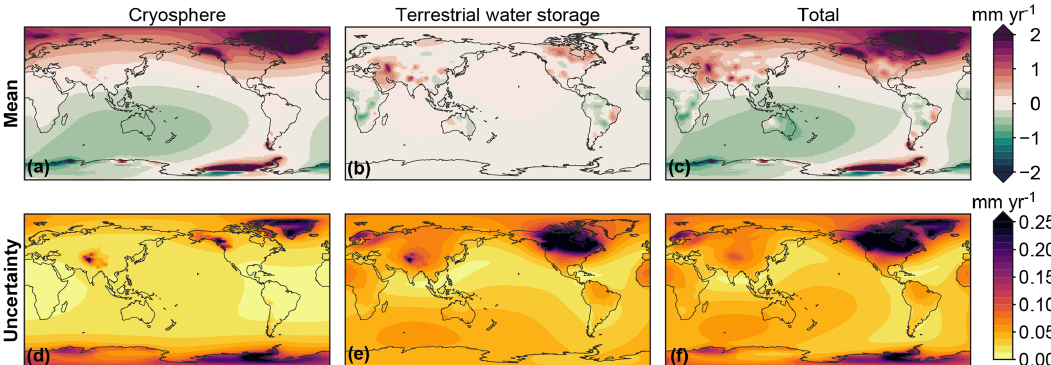
Figure 8. Trends in SED resulting from mass redistribution observed by GRACE, separated into the cryosphere contribution (sum of glacier and ice sheet contribution), the TWS contribution, and the total land mass contribution. The trends have been computed over the full GRACE time span (2002–2017). Panels (a) – (c) show the mean trend, and panels (d) – (f) show the